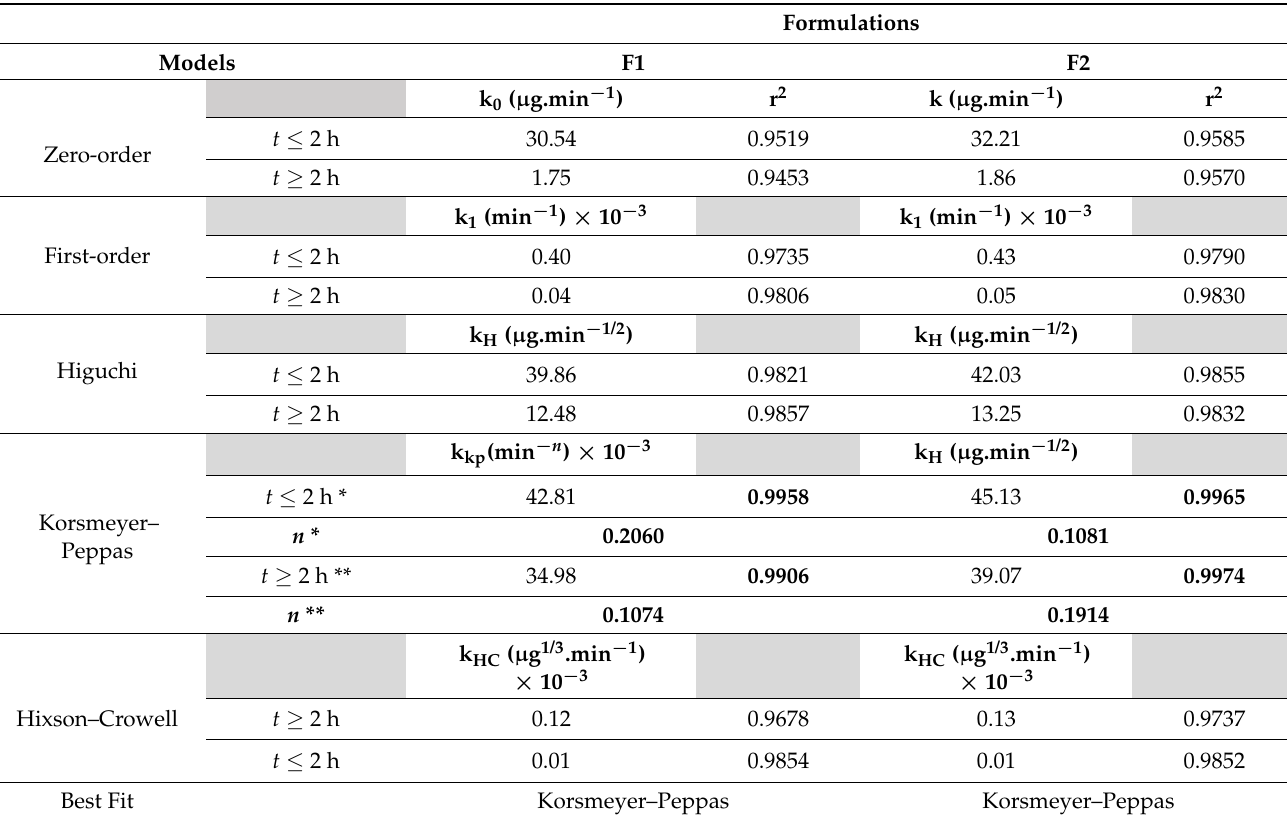
Table 2. Linear evaluation of in vitro PTX (pentoxifylline) release mathematical models from CS films.